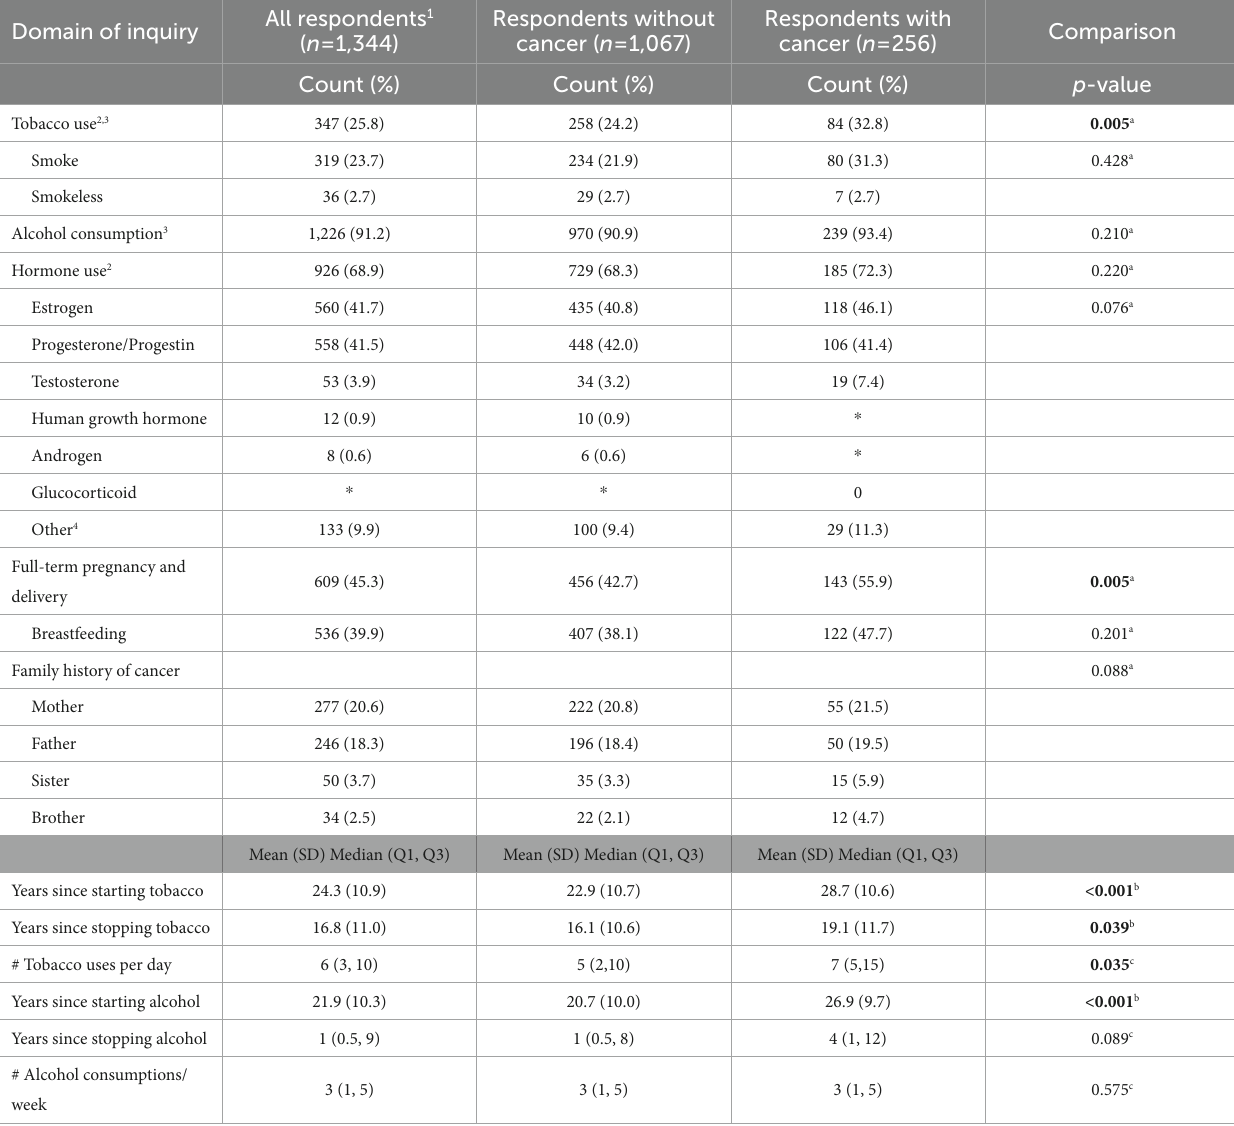
TABLE 3 Cancer risk factors of female firefighter survey respondents, by presence and absence of